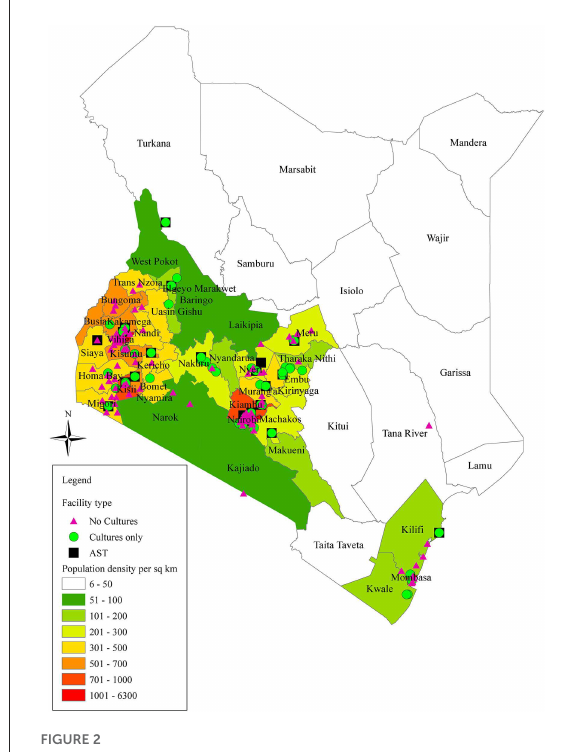
FIGURE2 Map of Kenya representing the geographic locations of the health facilities completing the survey and the population density by location. The figure was generated using pandas and GeoPandas software libraries in Python. Facility type (No cultures; lacking culture testing, Cultures only; performing cultures but no antimicrobial susceptibility testing; AST, Antimicrobial susceptibility